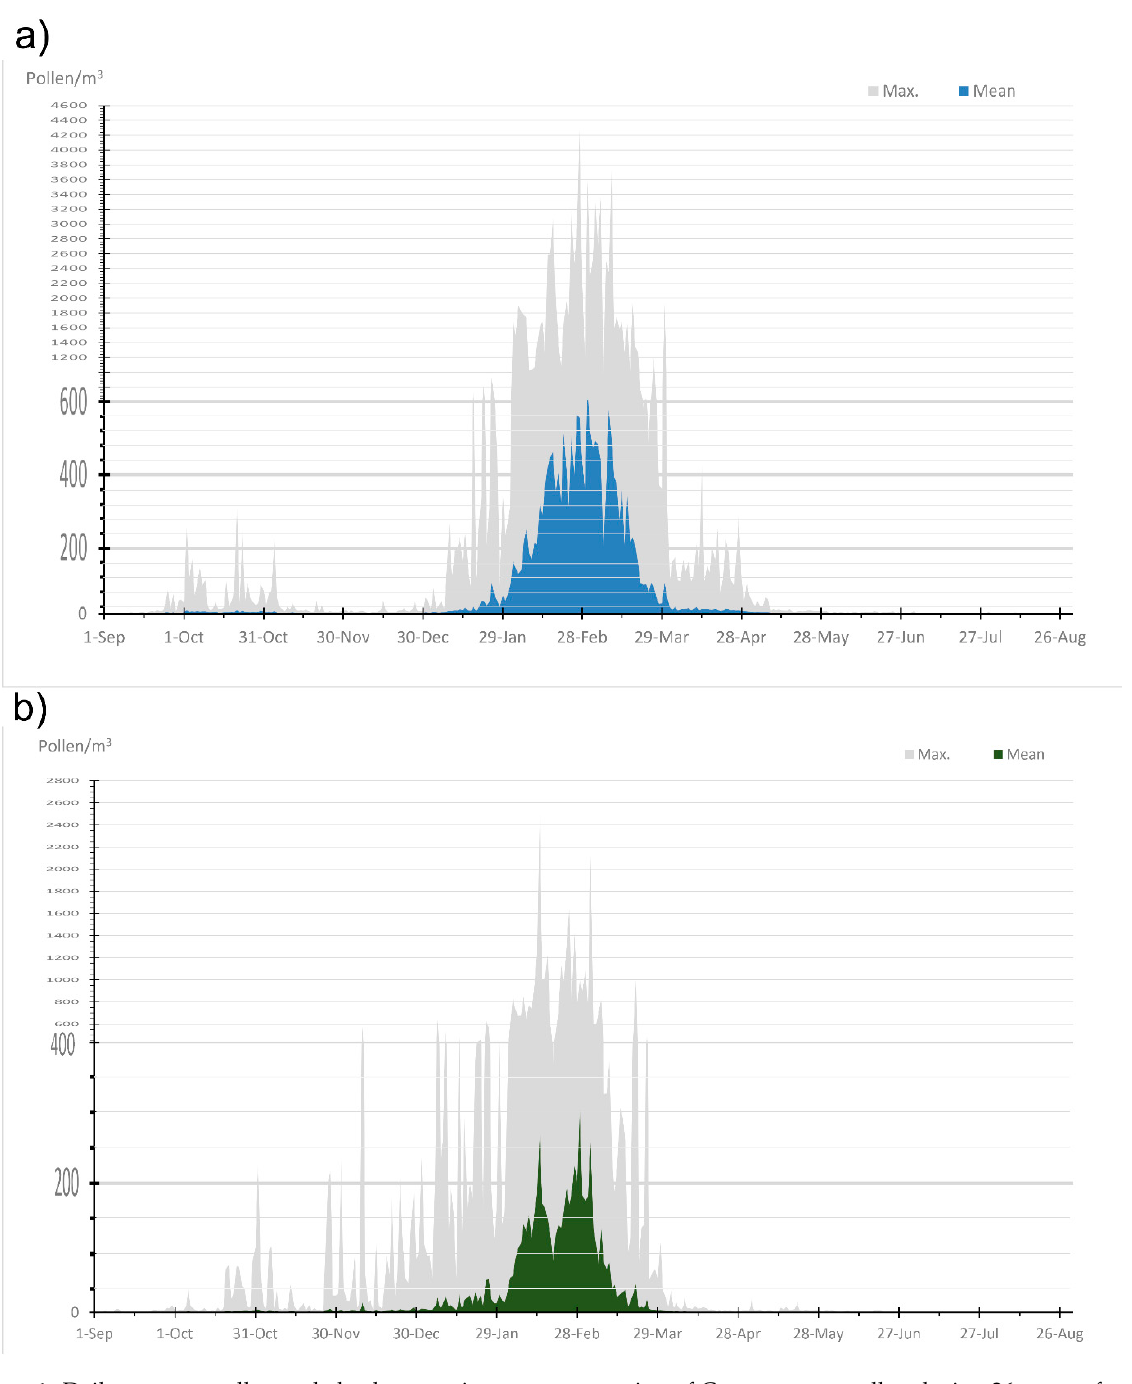
Figure 1. Daily average pollen and absolute maximum concentration of Cupressaceae pollen during 26 years of study period (1993–1994 to 2018–2019) expressed in pollen/m 3 : ( a ) Granada; ( b ) Córdoba.